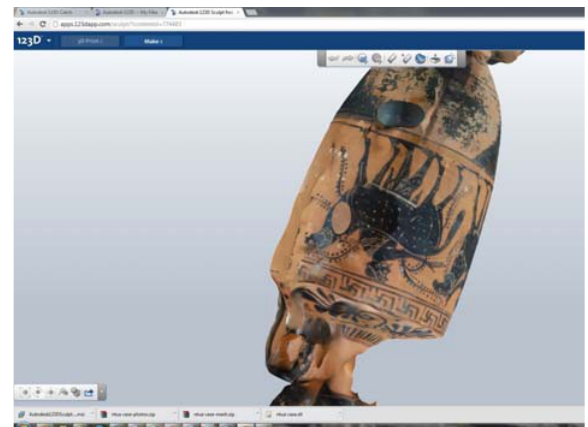
Fig. 14. Final 3D textured model created by the 123catch